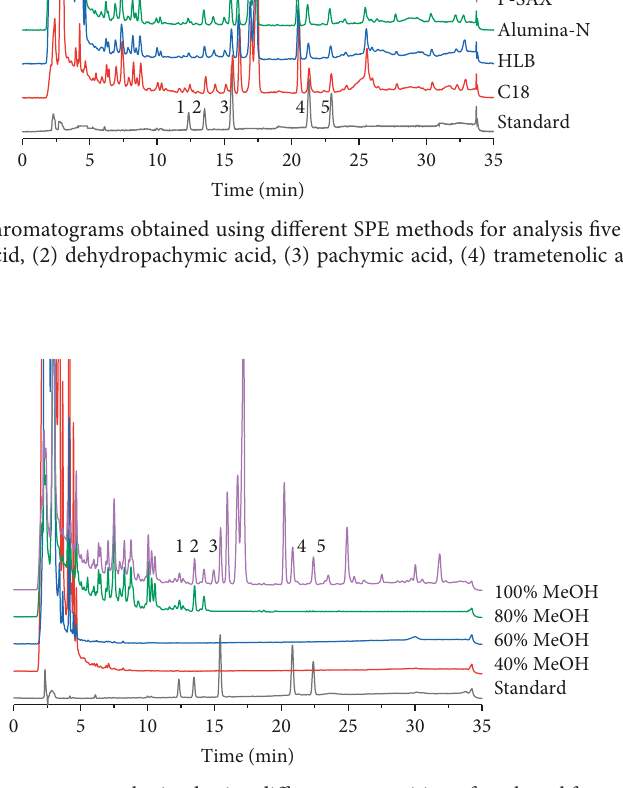
Figure 7: Comparison of HPLC chromatograms obtained using different composition of methanol for analysis five triterpene acids in LDC. (1) 3-O-Acetyl 16 α -hydroxytrametenolic acid, (2) dehydropachymic acid, (3) pachymic acid, (4) trametenolic acid, (5) dehydrotrametenolic